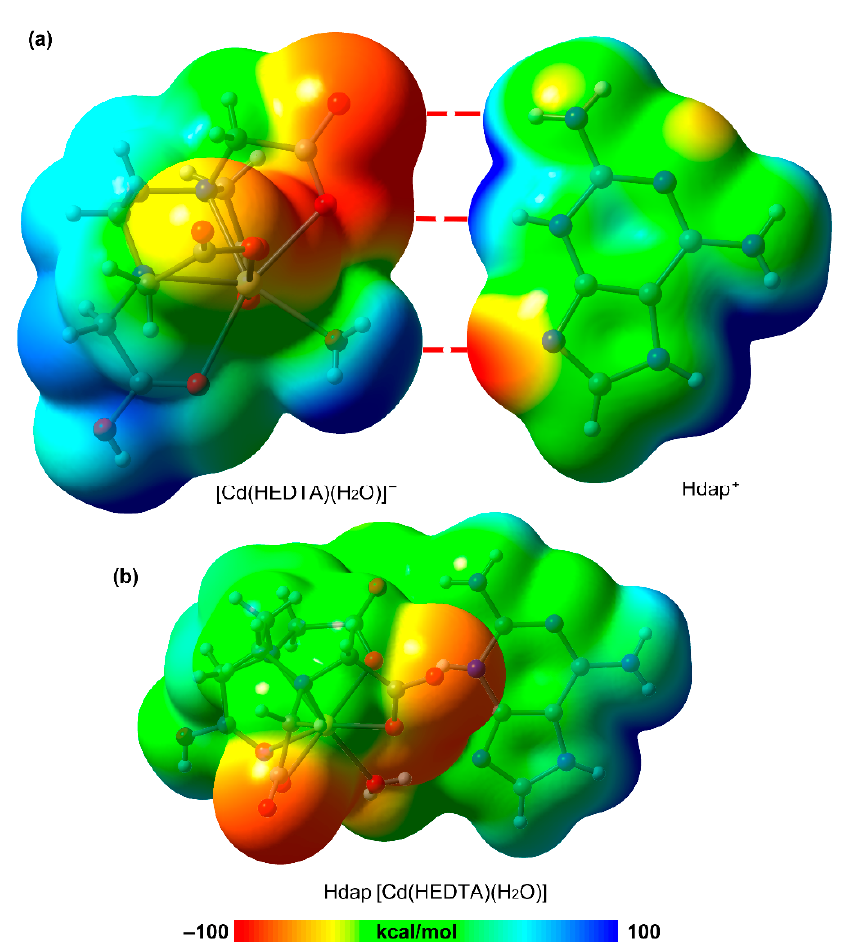
Figure 6. ( a ) MEP surfaces (0.001 a.u.) for [Cd(HEDTA)(H 2 O)] − and H 2 dap + highlighting the electropositive (blue) and electronegative (red) regions of each molecule. The dashed lines highlight a favorable electrostatic interaction between these two species. ( b ) MEP surface (0.001 a.u.) of the assembly at the PBE1PBE/def2-TZVP level of theory.